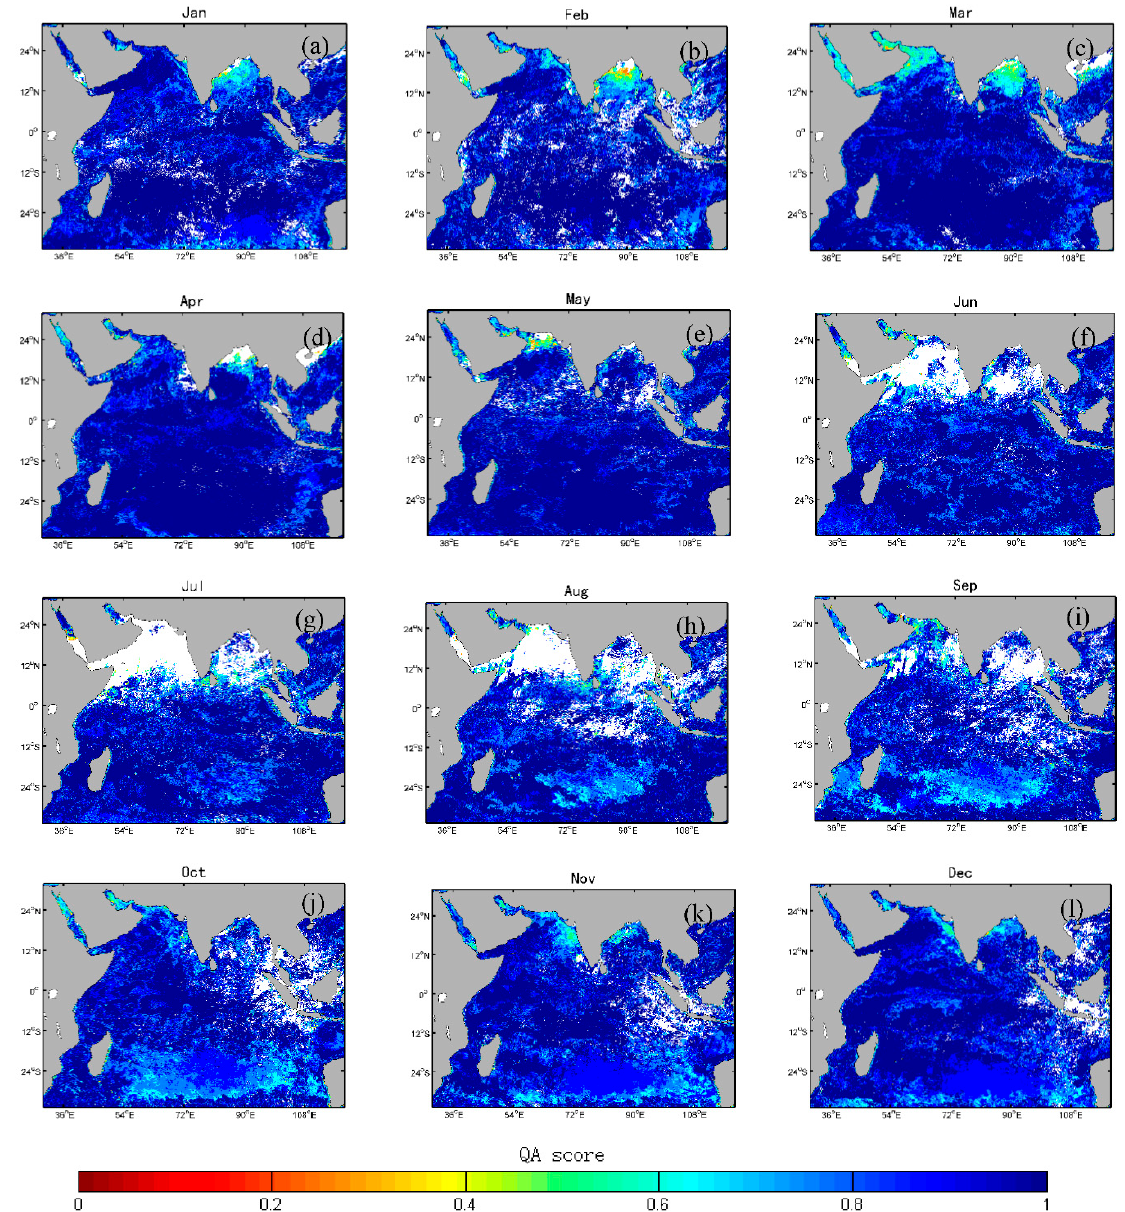
Figure 7. Monthly QA scores of MODIS–Terra level 3 R rs ( λ ) products (R2018) from January ( a ) to December ( l ) in 2016 in the IO. White color represents invalid pixels.